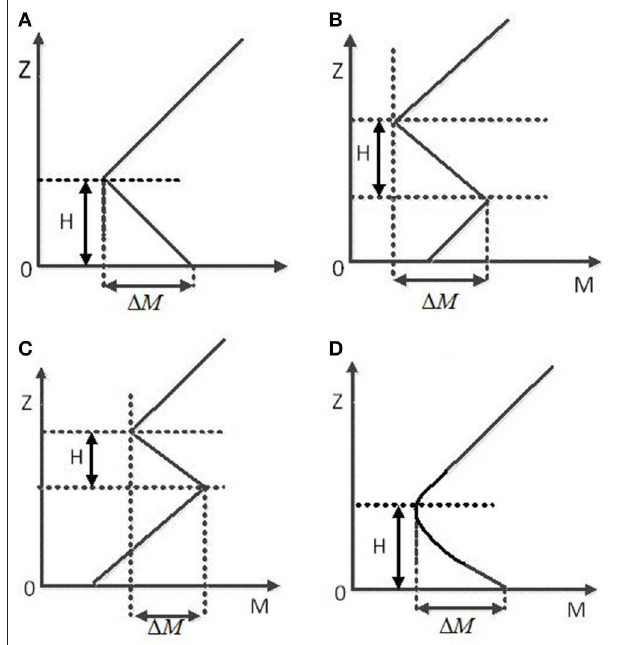
FIGURE 1 | Atmospheric duct definitions: (A) surface duct; (B) surface-based duct; (C) elevated duct; (D) evaporation duct. (A–C) usually appears over land. The difference between (B) and (C) is that the atmospheric corrected refractivity M at the second inflection point of (B) is smaller than that at the ground, while (C) is larger than that at the ground. (D) usually appears over the ocean and its height h does not exceed 40m.